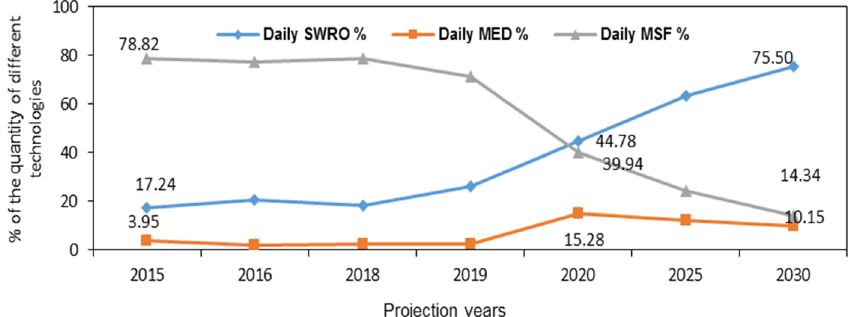
Figure 2. Trend of expected desalination technologies in the 2030 projection plan. MED, multi-effect desalination.